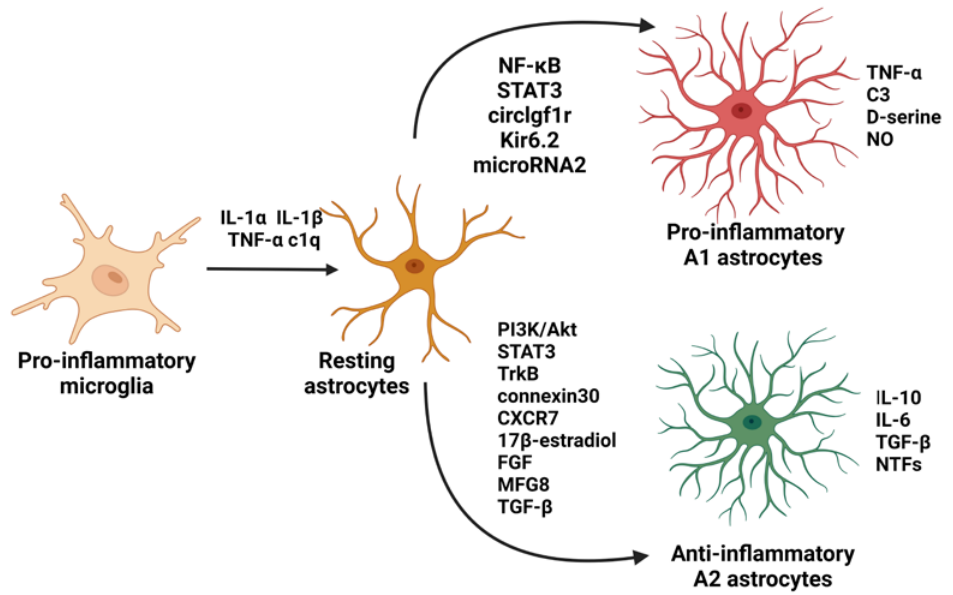
Figure 2. Reactive astrocytes are induced by classically activated neuroinflammatory microglia via secretion of interleukin (IL)-1 α , IL-1 β , tumor necrosis factor-alpha (TNF- α ), and complement component 1q (c1q). Astrocytes show dual nature. The signaling molecules involved in the induction of pro-inflammatory A1 astrocytes are nuclear factor kappa-light-chain-enhancer of activated B cells (NF- κ B), signal transducer and activator of transcription 3 (STAT3), circlgf1r, Kir6.2, and microRNA2, while signaling molecules responsible for the induction of A2 astrocytes are phosphoinositide 3-kinase (PI3K)/protein kinase B (Akt), STAT3, tropomyosin receptor kinase B (TrkB), connexin30, chemokine receptor 7 (CXCR7), 17 β -estradiol, fibroblast growth factor (FGF), milk fat globule epidermal growth factor 8 (MFG8), and transforming growth factor- β (TGF- β ). A1 astrocytes release interleukin (IL)-1 β , TNF- α , and C3 components to propagate the neuroinflammatory response. They also release D- serine and nitric oxide (NO), which may contribute to excitotoxicity. A2 astrocytes appear to release anti-inflammatory compounds, such as neurotrophic factors (NTFs), IL-10, IL-6, and TGF- β , and promote the survival and growth of neurons and reparative functions. The figure was created with BioRen- der.com.